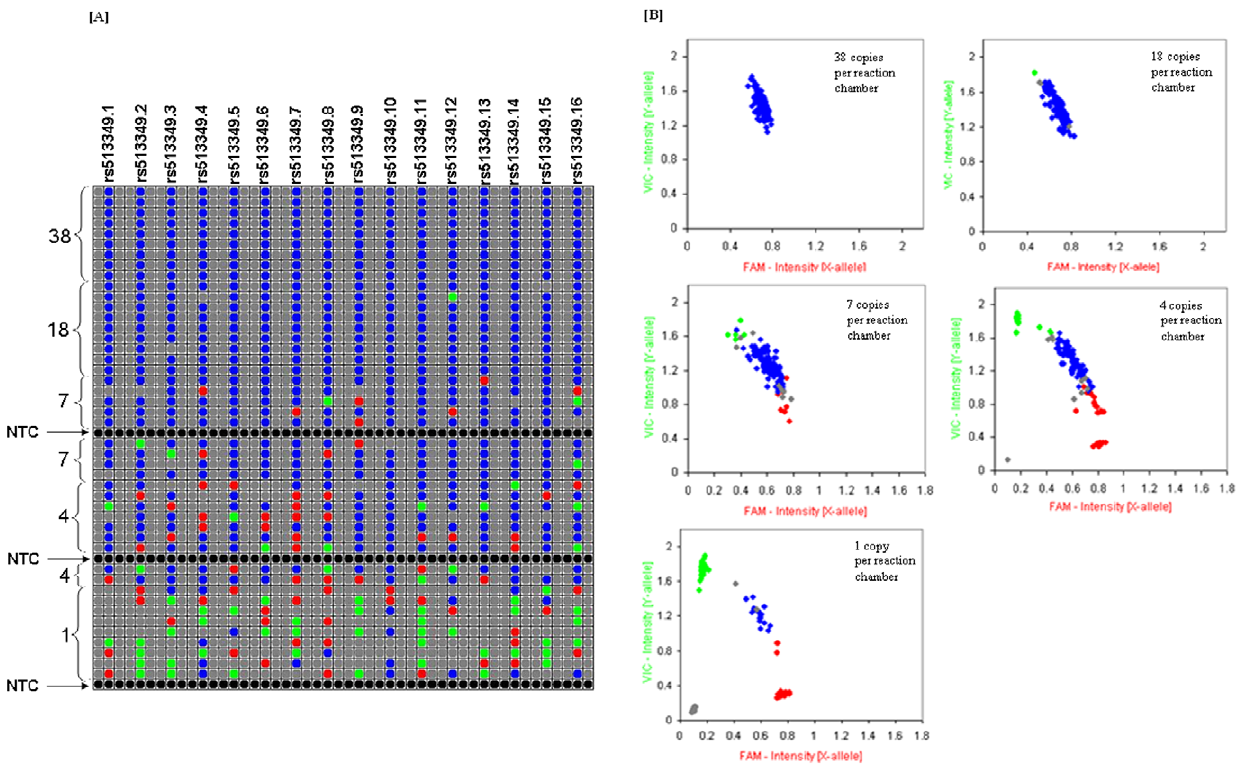
Figure 2. Effect of reaction DNA copy number on genotype call accuracy for a heterozygous (pq) sample. Call map view [A] and scatter plots [B] of the genotype calls from reaction chambers containing predicted 38, 18, 7, 4 and 1 copies(y). The genotype call ( pp , qq and pq ) for each reaction is denoted in ‘ red ’, ‘ green ’ and ‘ blue ’, respectively. No Call and NPC are denoted in ‘grey’ and NTCs in ‘black’. SNP-GT assay (rs513349) was loaded into sixteen separate assay inlets evenly spaced across the 48.48GT array. The remaining inlets were loaded with a NPC as stated in the